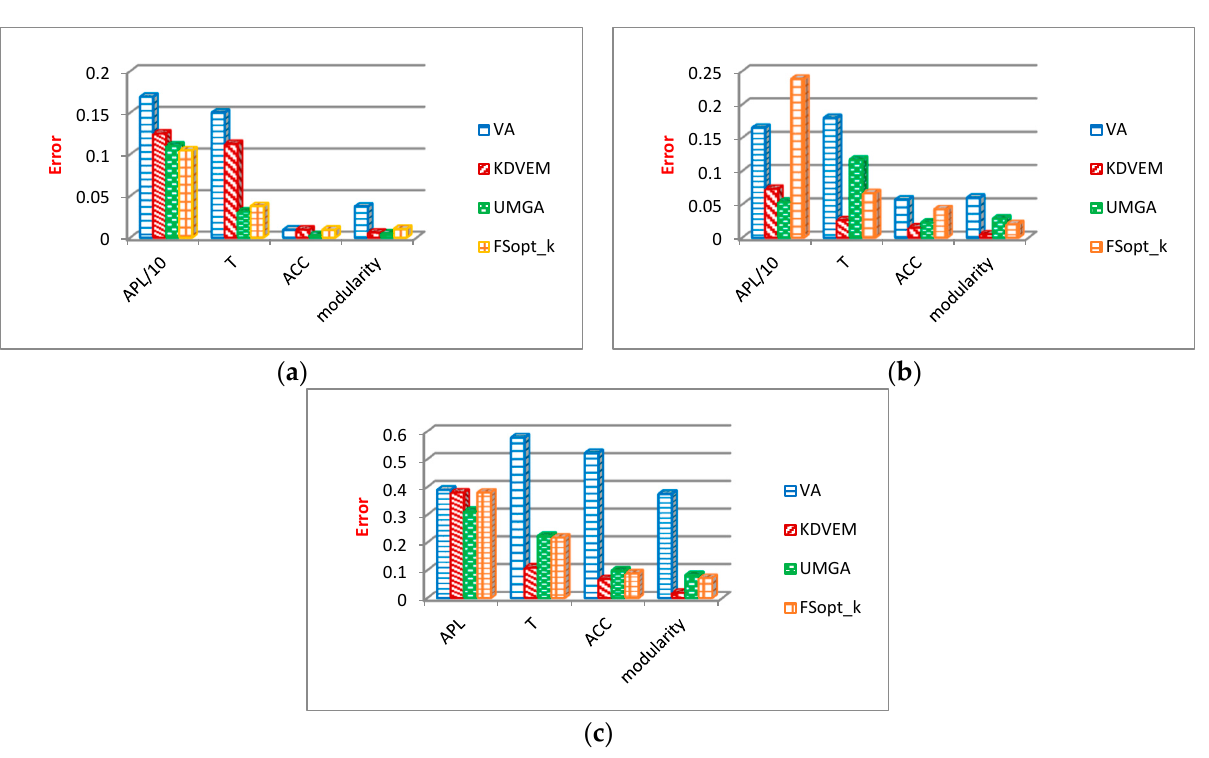
Figure 8. Comparison of error values of the algorithms on Dolphins dataset for ( a ): ℒ = 0.05 , ( b ): ℒ = 0.1 , and ( c ): ℒ = 0.2 .